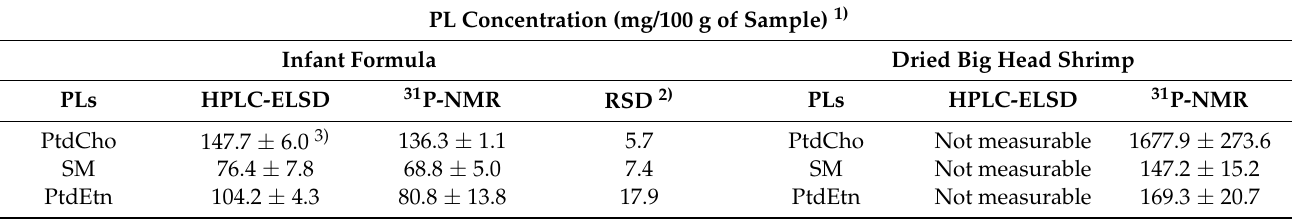
Table 1. Quantitative value (mg/100 g of sample) of phospholipids from infant formula and the dried big head shrimp as determined by HPLC-ELSD and 31